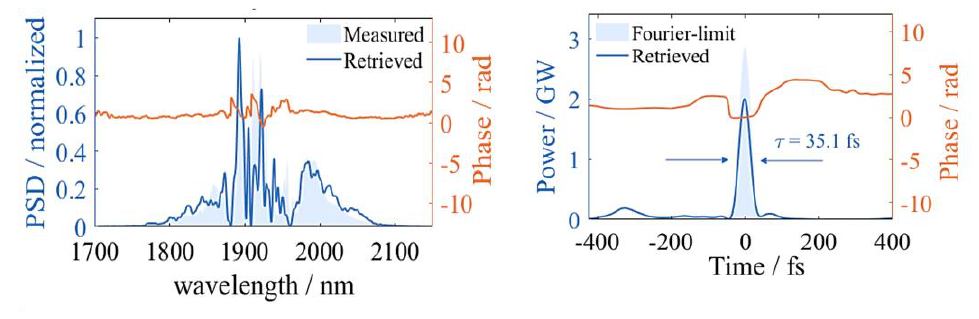
Fig. 1 FROG measurement of the post compressed MPC output. Left plot, measured and retrieved spectrum. Right plot, retrieved pulse and corresponding